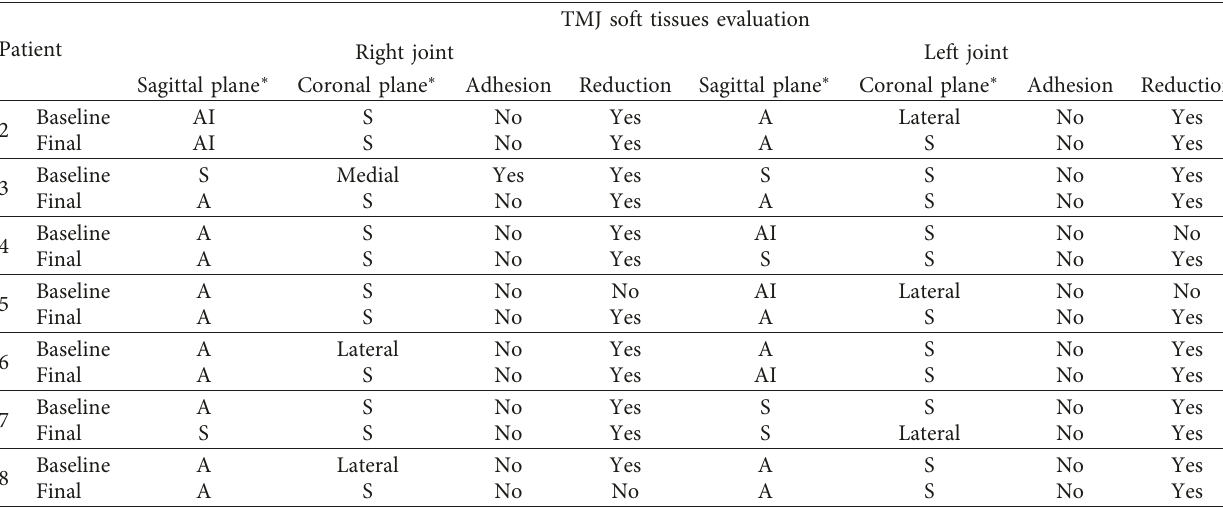
Table 4: MRI evaluation of TMJ disc position and adhesion at baseline and at final (6 months)